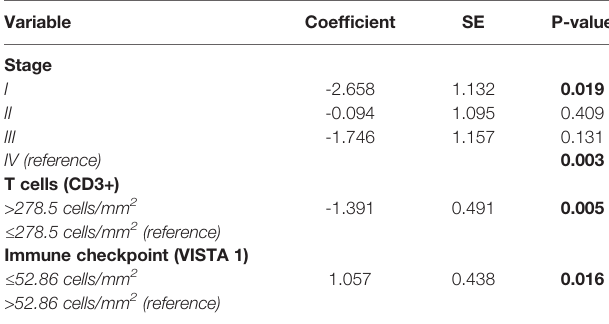
TABLE 3A | Cox proportional hazard model analysis of survival time, controlled for tumor pathological stages I, II, and III. Variable